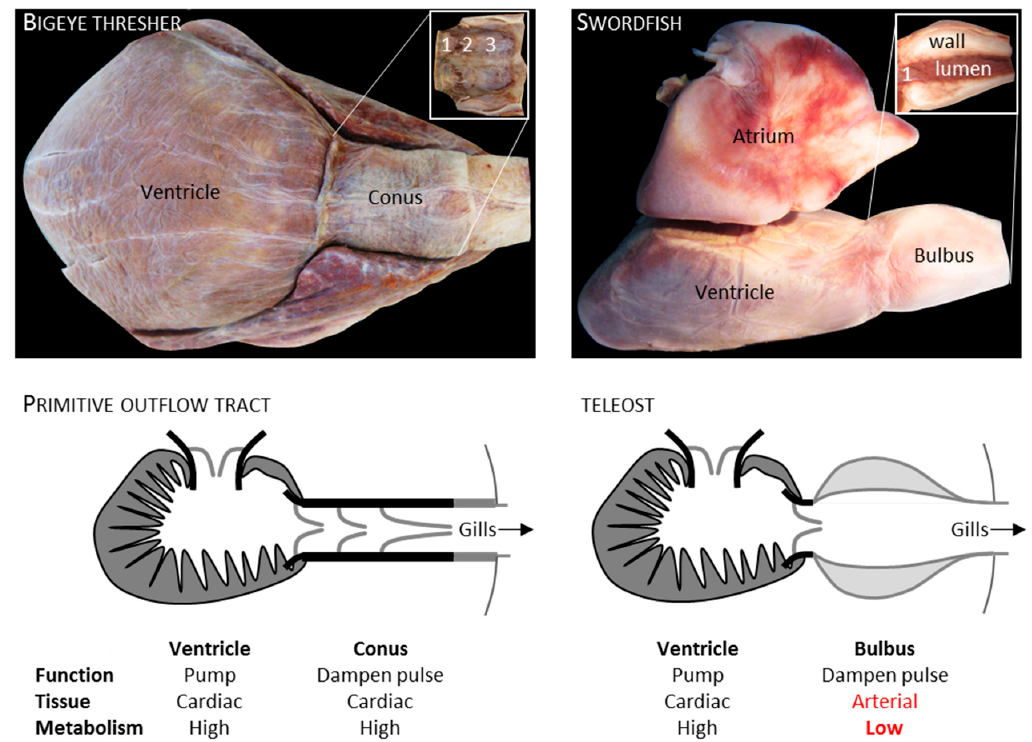
Figure 5. Arterial pole of fish hearts. The heart (158 g) of a 304 cm long bigeye thresher ( Alopias superciliosus ), a shark, had a myocardial outflow tract (Conus, ventral view) that comprised 8.9% of the cardiac mass. In the insert, the conus has been isolated, cut longitudinally, and folded out, exposing its three rows of valve leaflets (1–3, 1st to 3rd row of valve leaflets). The heart of an approximately 50 kg swordfish ( Xiphias gladius ), a teleost, had an arterial outflow tract (Bulbus, view from the right). In the insert, the interior is exposed of the left half of the bulbus showing its thick arterial wall (1, only 1 row of valve leaflets). The categorization of metabolism as being high or low is based on values for mammals [96,97].